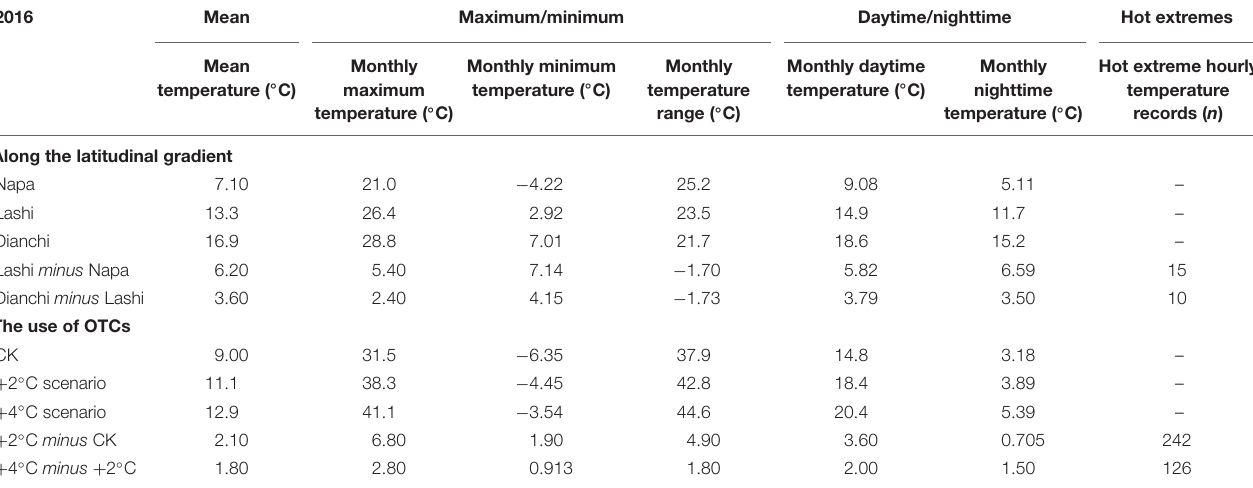
TABLE 1 | Temperature patterns of two warming experiments averaged over a year. 2016 Mean